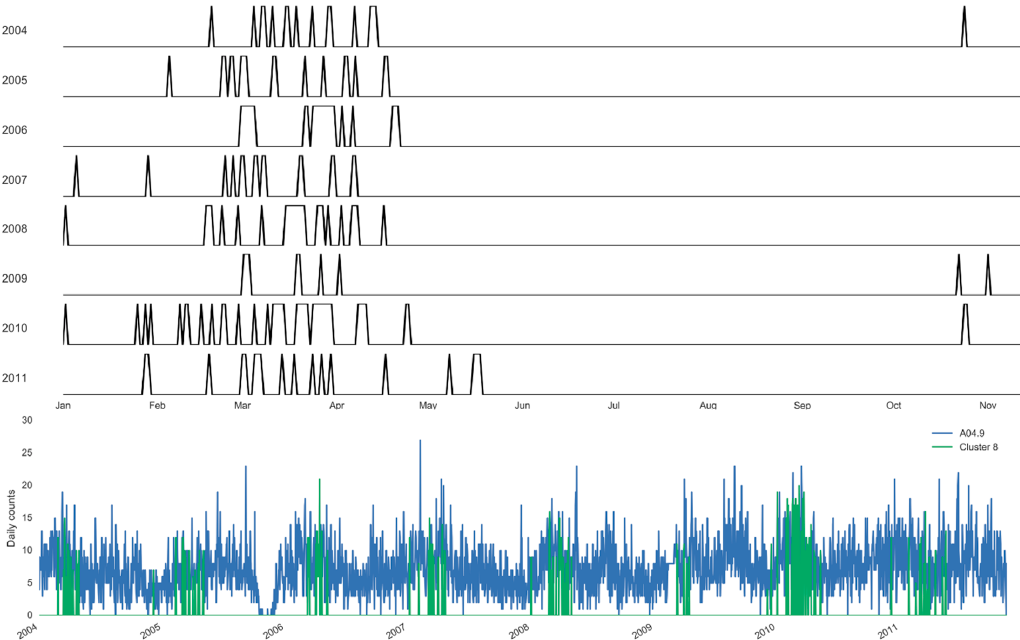
Figure 7. Sampling distribution of days selected annually and the corresponding time series for Cluster 5 of salmonellosis, A02.8 (Set 1) in Barnaul, Russia in 2004–2011.